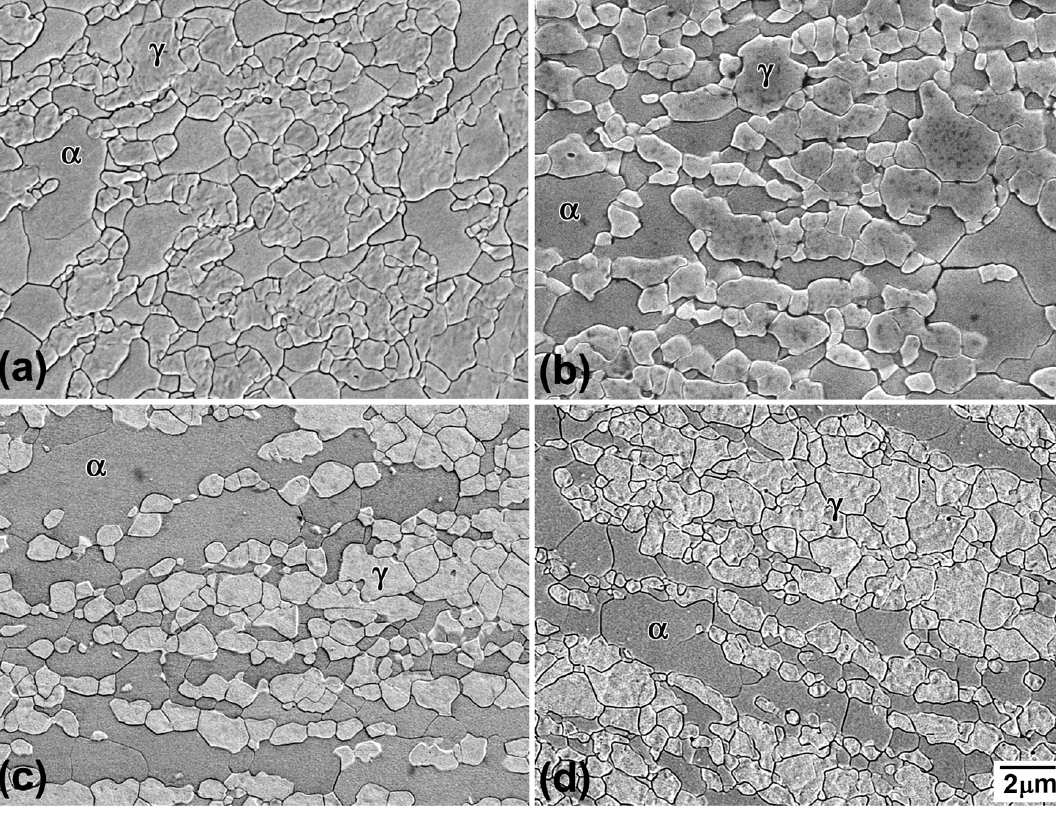
Fig. 10. Scanning electron microscopy (SEM) images of friction stir welded joints: SZ of UNS (a) SS32101, (b) S32205, (c) S32750, and (d)